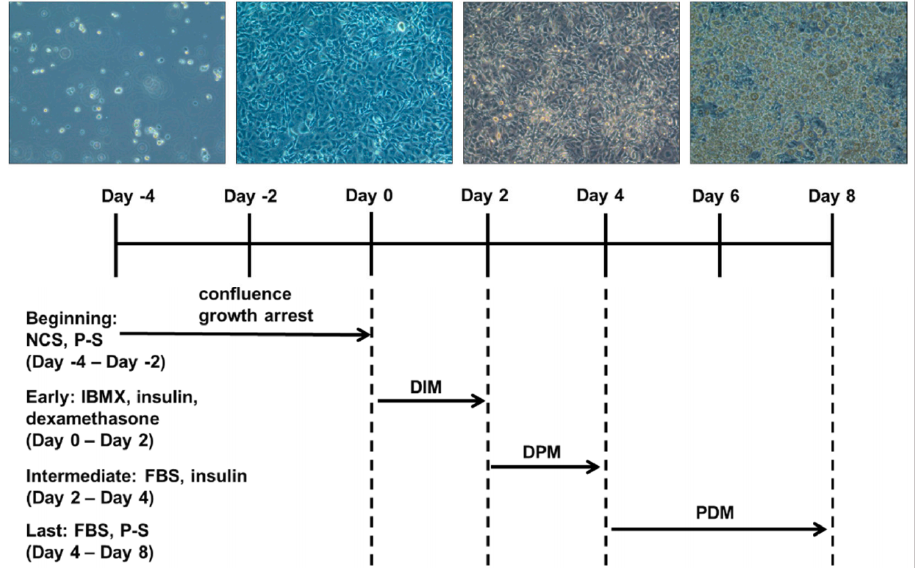
Figure 8. 3T3-L1 cell differentiation